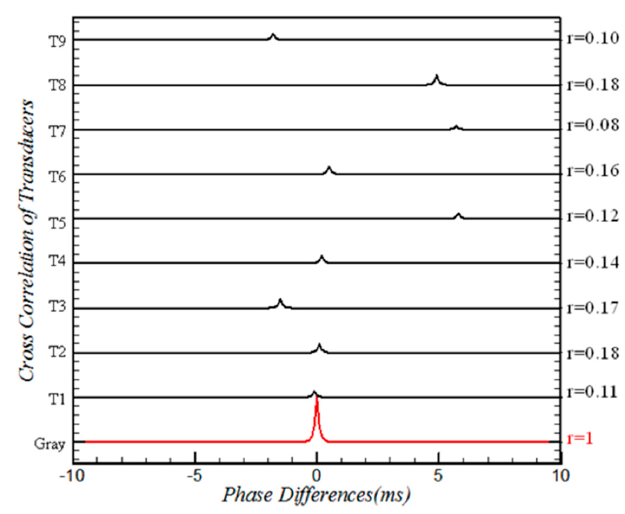
Figure 16. Phase analysis of T1–T9 and the grayscale ( t = 3 s). Aerospace 2019 , 6 , x FOR PEER REVIEW